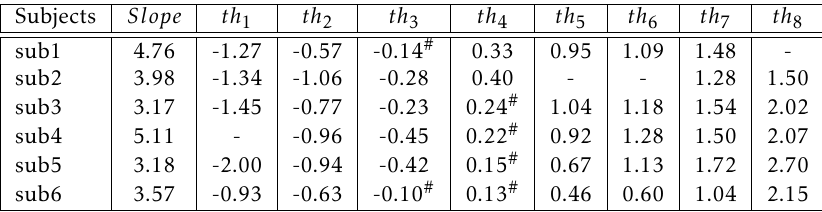
Table 1. Estimated IRT parameters for “Pleasant” scale